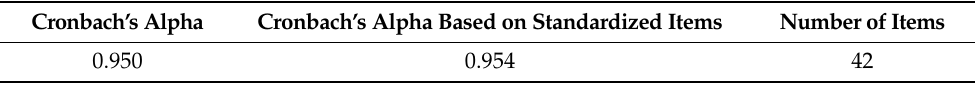
Table 5. Reliability statistics for the university library space user experience questionnaire.